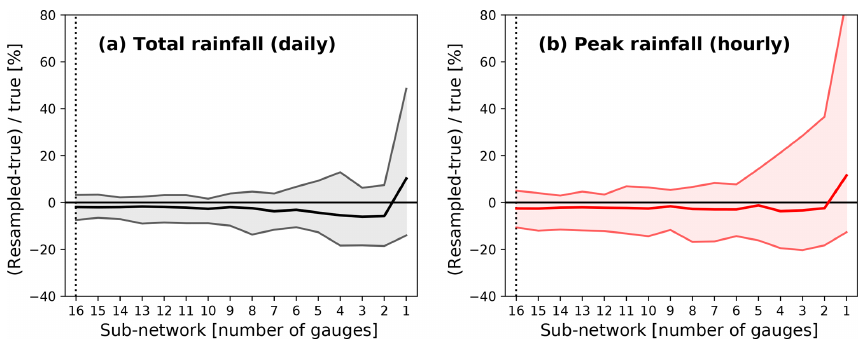
Figure 7. Dependence of the accuracy of (a) daily rainfall and (b) hourly peak intensity on the number of gauges. 71 heavy rain events are considered. The y axis displays the relative difference between resampled and true rainfall. Resampled rainfall is calculated from n -gauge sub-networks, while true rainfall is calculated using the full density WEGN network. The thick lines show the median, and the shaded areas show the 10th to 90th percentile